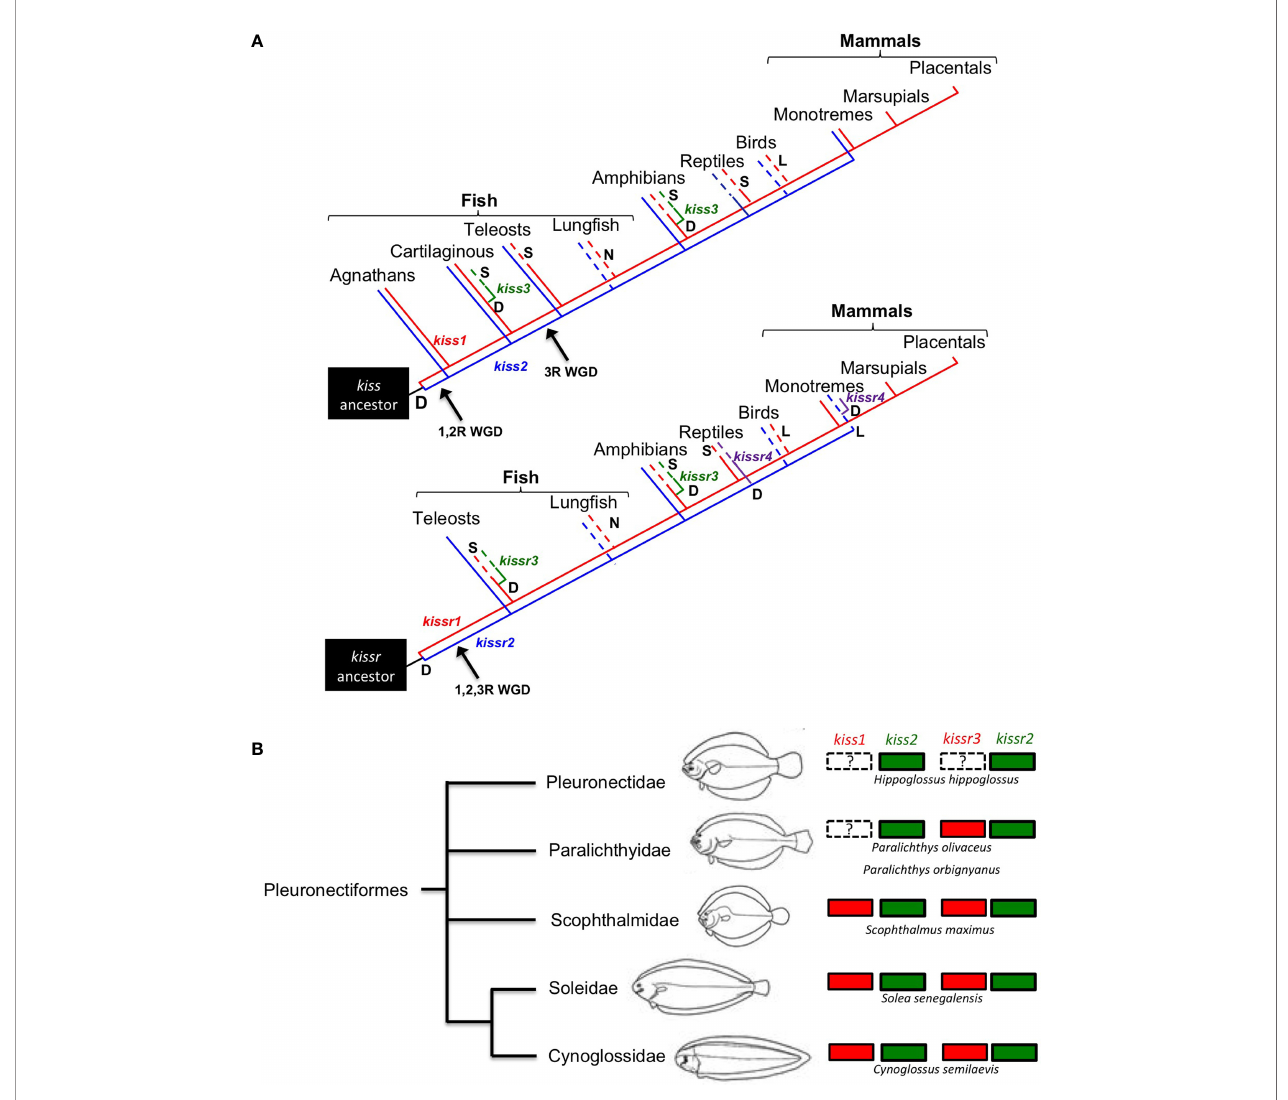
FIGURE 1 | (A) kiss and kissr gene evolution in vertebrates derived from available information. D = gene duplication, L = gene lost, S = gene lost in some species, N = gene not searched. (Modi fi ed from 7). (B) Consensus tree of fl at fi sh relationships proposed by Chapleau (55), fi gure modi fi ed from Chanet et al.